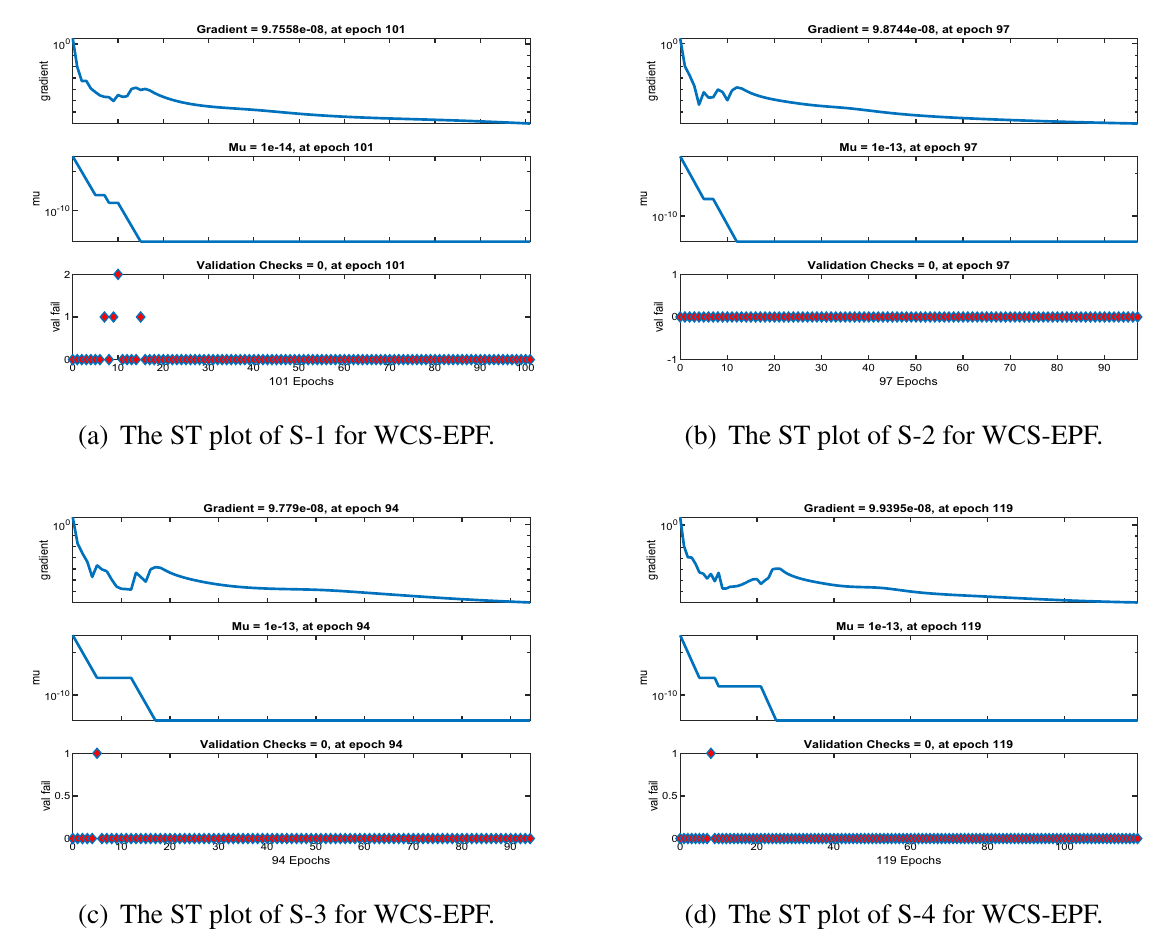
(d) The ST plot of S-4 for WCS-EPF. Figure 12. The state transition (ST) for Case 2 in Vogel’s